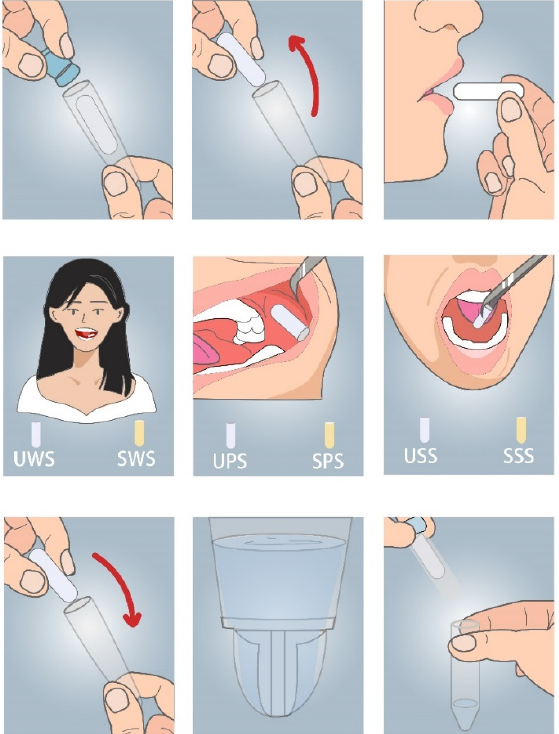
Figure 1. Six methods for collecting saliva samples, UWS/SWS: the swab in the test tube was taken out and put in the mouth to chew for 3 min; UPS/SPS: the swab was placed near the left parotid duct, and it was taken out after 3 min; USS/SSS: the swab was put under the tongue, and it was taken out after 3 min .